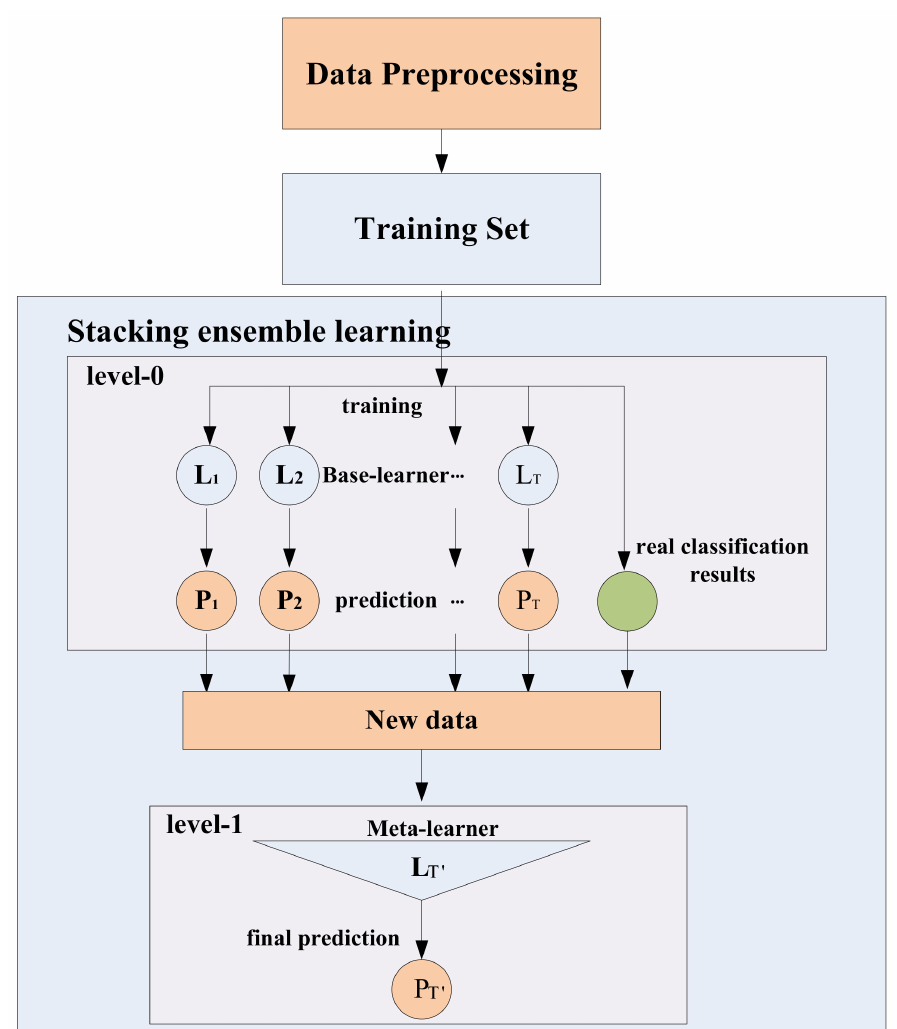
Figure 5. Stacking ensemble learning